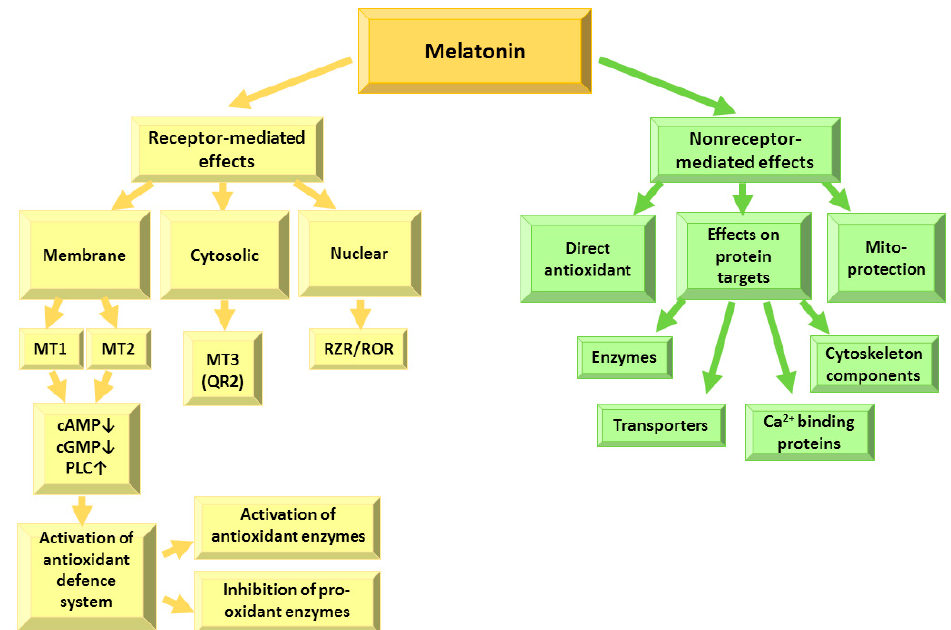
Figure 2. Receptor-dependent and receptor-independent effects of melatonin. MT—melatonin receptor; cAMP—adenylyl cyclase; cGMP—guanylyl cyclase; PLC—phospholipase C; QR2—quinone reductase 2; RZR/ROR—nuclear retinoid Z receptor.